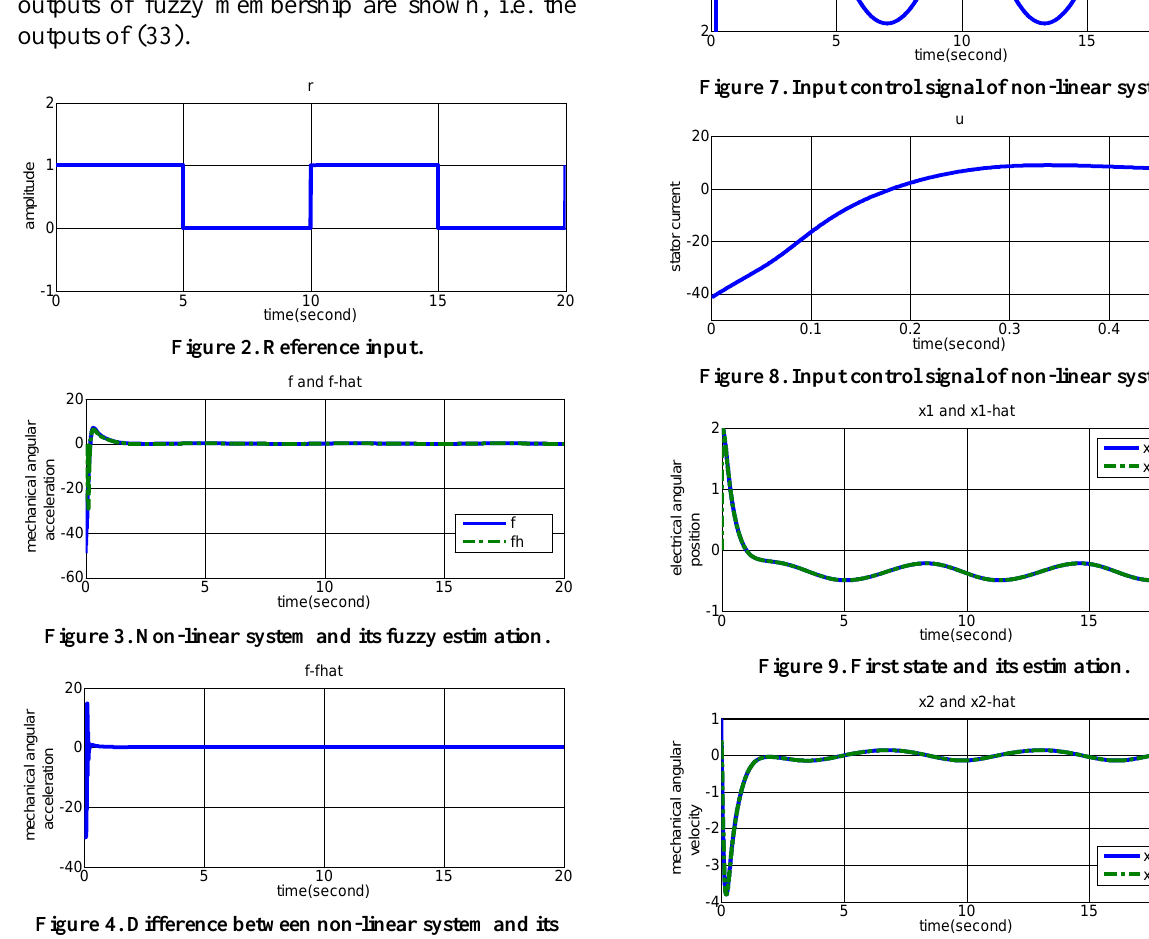
Figure 6. Input control signal of non-linear system.